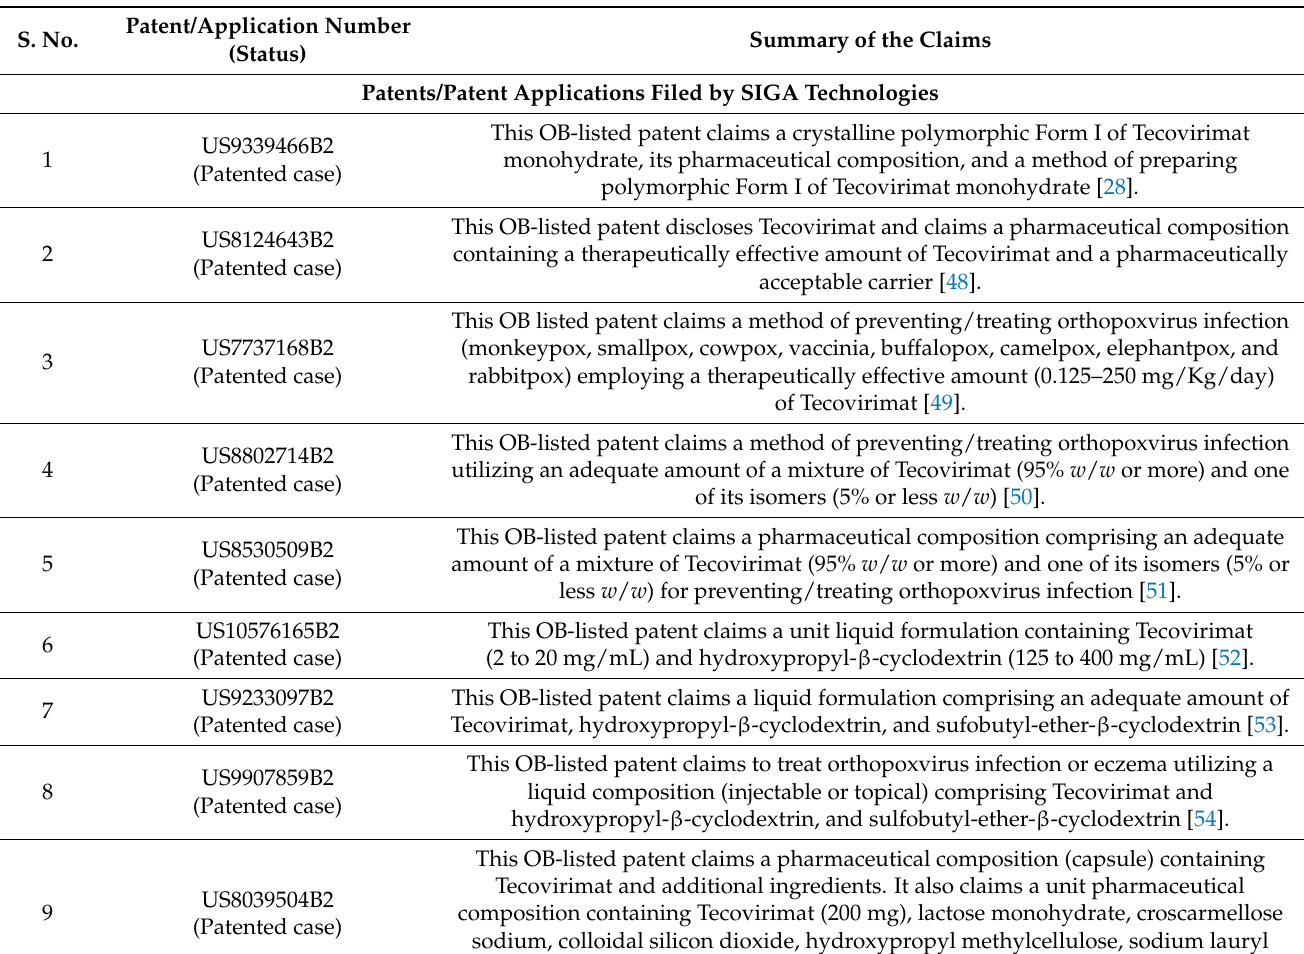
Table 4. Summary of the critical patents/patent applications related to